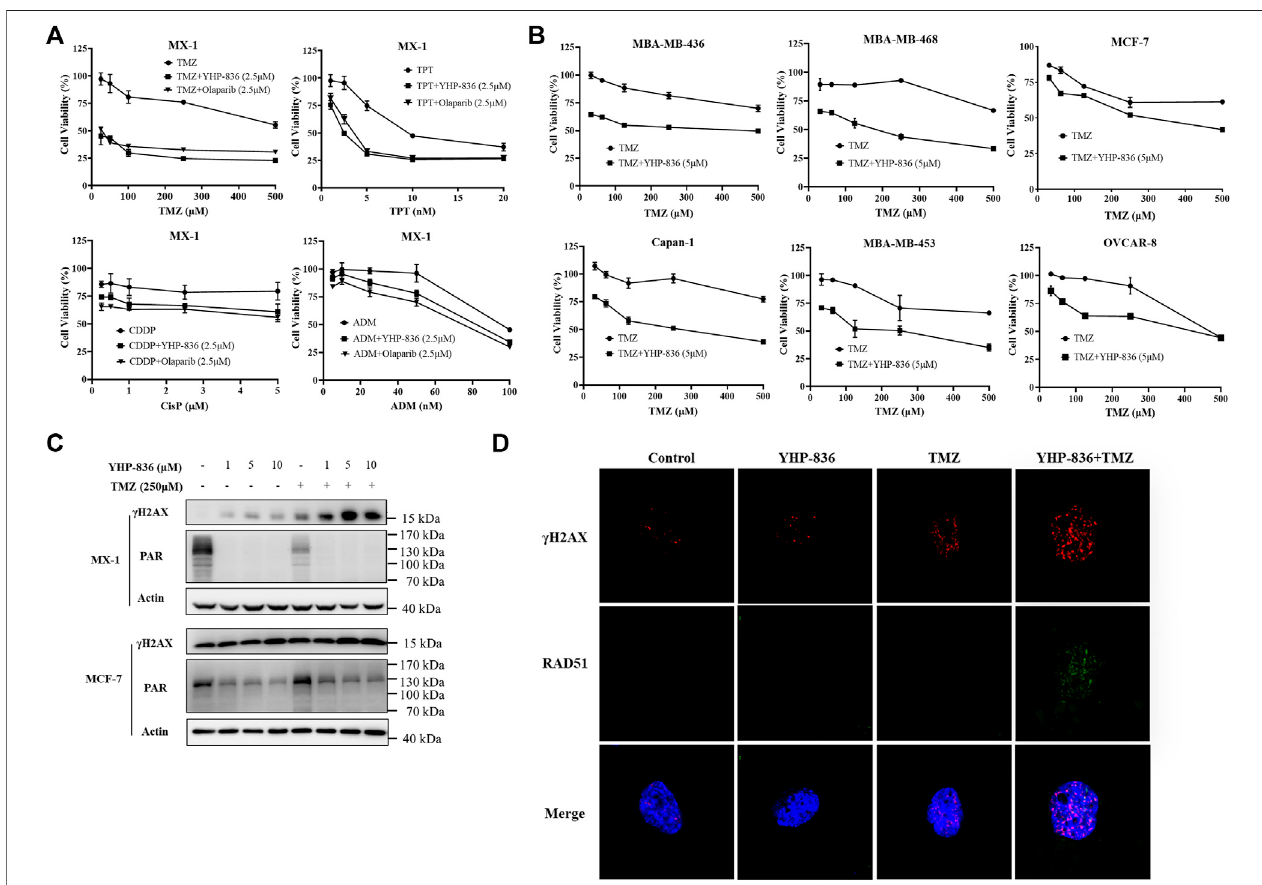
FIGURE4| ThepotentialeffectsofYHP-836onchemotherapyagents invitro . (A) YHP-836enhancedthecytotoxicityofTMZ,TPT,CDDP,andADMinMX-1cells. The cells exposed to TMZ, TPT, CDDP, or ADM alone or in combination with YHP-836 (2.5 μ M) or olaparib (2.5 μ M) for 72 h. (B) YHP-836 enhanced the cytotoxicity of TMZ in various cancer cells. The cells were exposed to TMZ alone or in combination with YHP-836 (5 μ M) for 72 h. (C) The levels of γ H2AX increased in both MX-1 and MCF-7 cells treated with TMZ (250 μ M) combined with different concentrations of YHP-836 (1, 5, 10 μ M) for 72 h. (D) Immuno fl uorescent staining of γ H2AX and RAD51 in MCF-7 cells. The cells were treated with YHP-836 (5 μ M), TMZ (250 μ M), or a combination for 24 h.